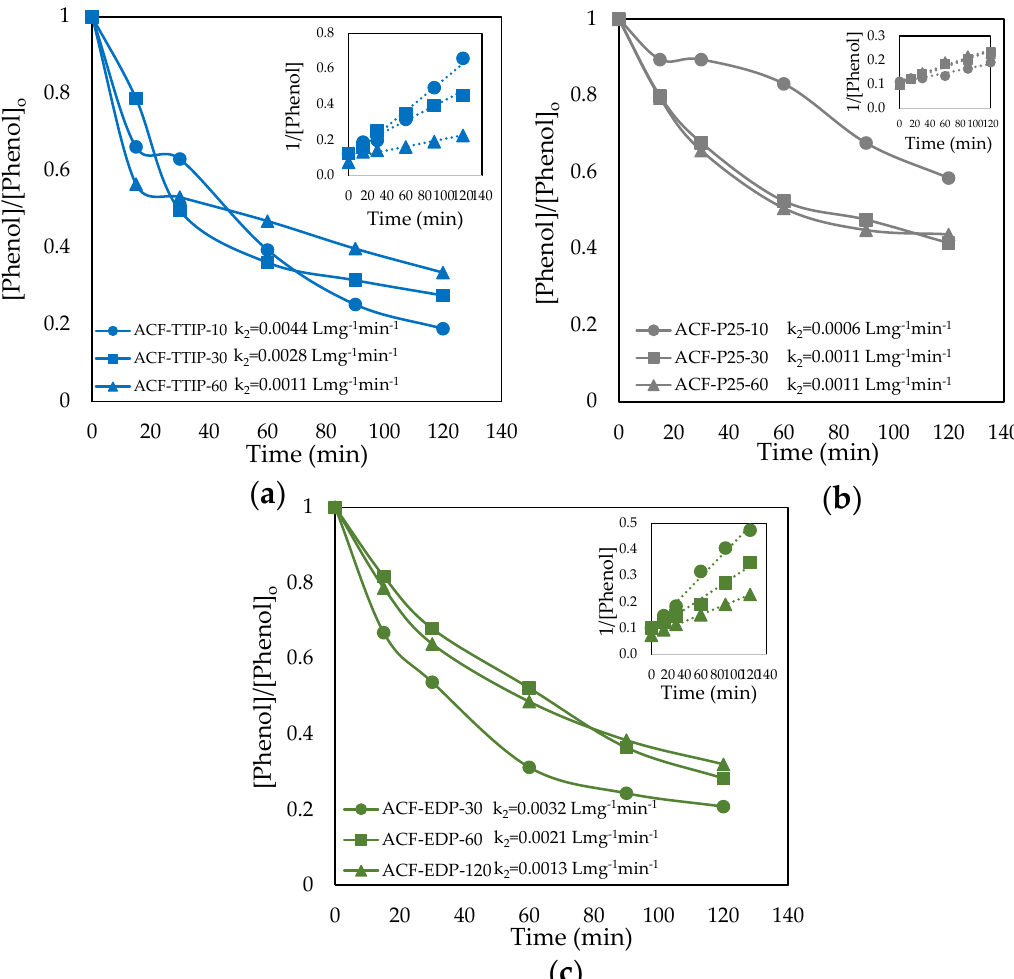
Figure 3. Kinetics of phenol adsorption on ( a ) ACF-TTIP, ( b ) ACF-P25, and ( c ) ACF-EDP composite ACF / TiO 2 adsorbents (inset: second-order kinetic graphs and respective rate constants).